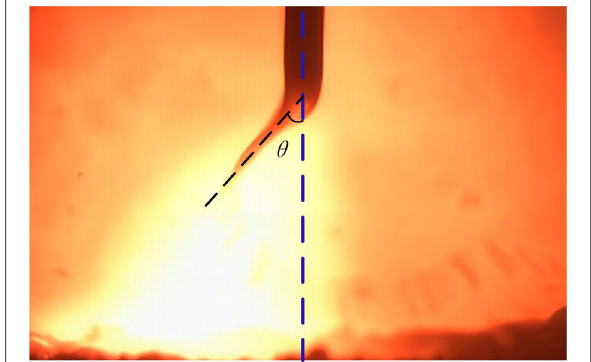
Figure 11 Metal rotating angle measurement schematic